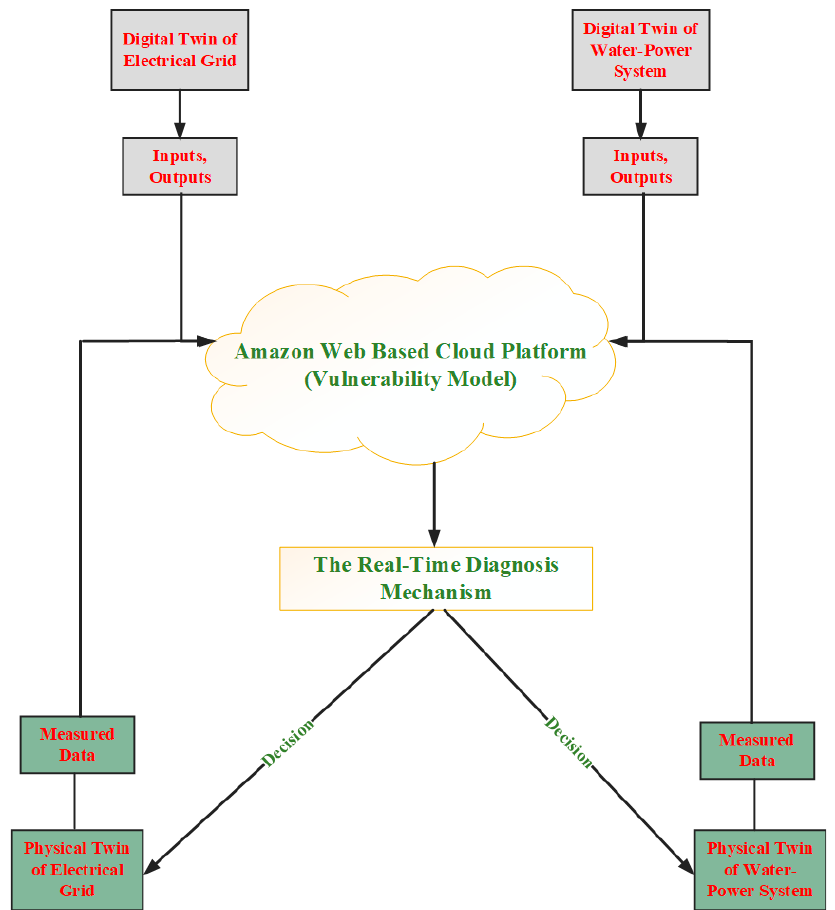
Figure 4. A digital twin model for the proposed system.